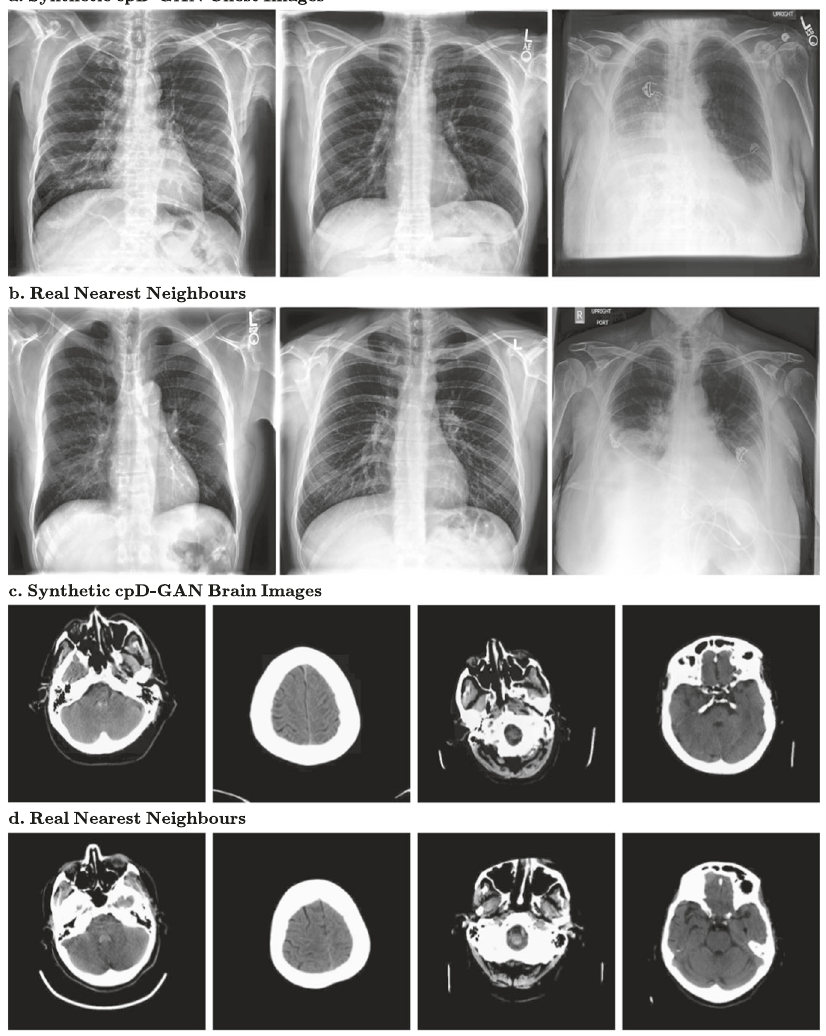
Fig. 4 Randomly sampled synthetic images generated by the cpD-GAN and real nearest-neighbour images from the training. a Synthetic chest radiographs at 512 × 512 pixels. b Nearest matching real images found in the chest radiograph training set. c Synthetic brain computed tomography (CT) scans at 256 × 256 pixels. d Nearest matching real images found in the brain CT training